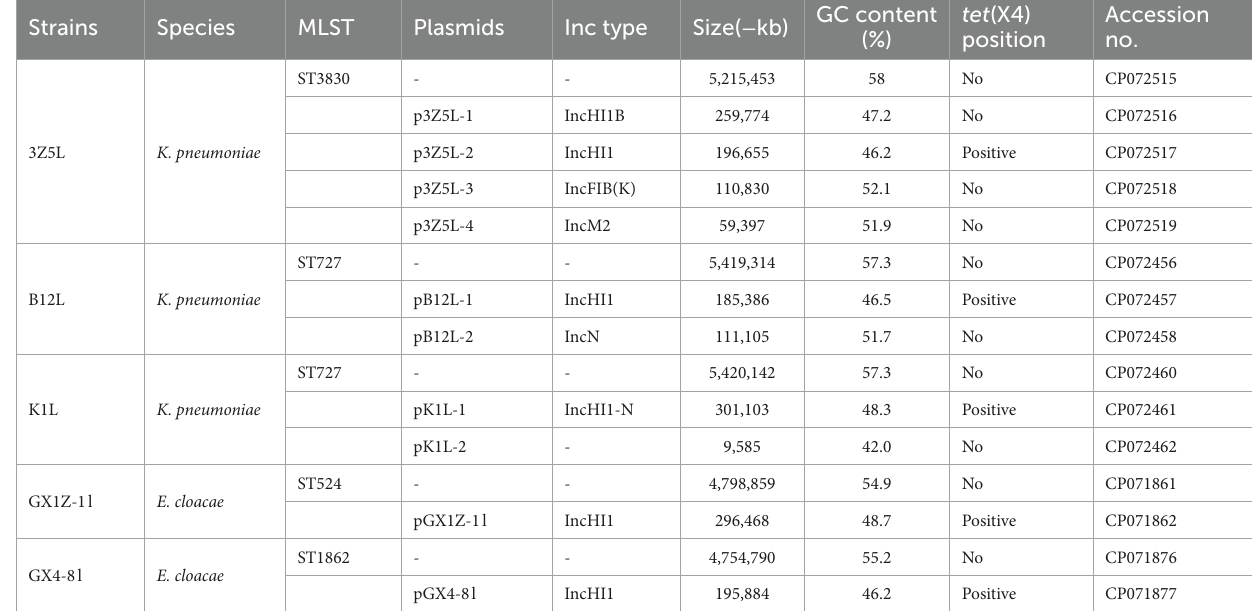
TABLE 1 The genome characteristics of the K. pneumoniae , E. cloacae and Enterobacter hormaechei strains. Strains